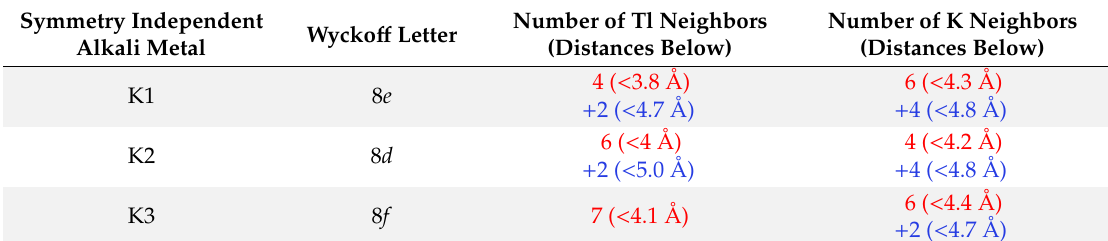
Table 10. Surrounding atoms of the symmetry inequivalent alkali metal positions in KTl (space group Cmce ). The color-coding refers to the color of the contacts in Figure 9.